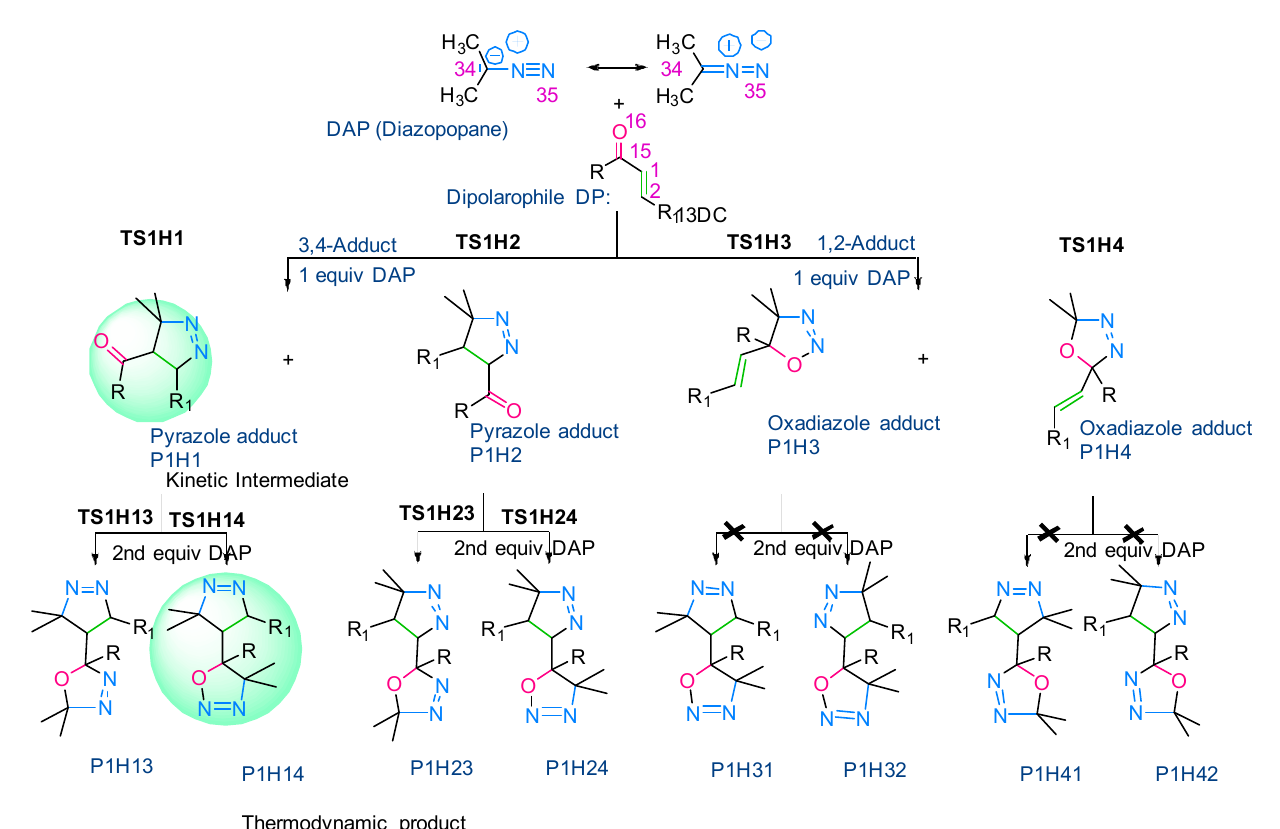
Figure 3. 1,3-dipolar cycloaddition between DAP and DP.